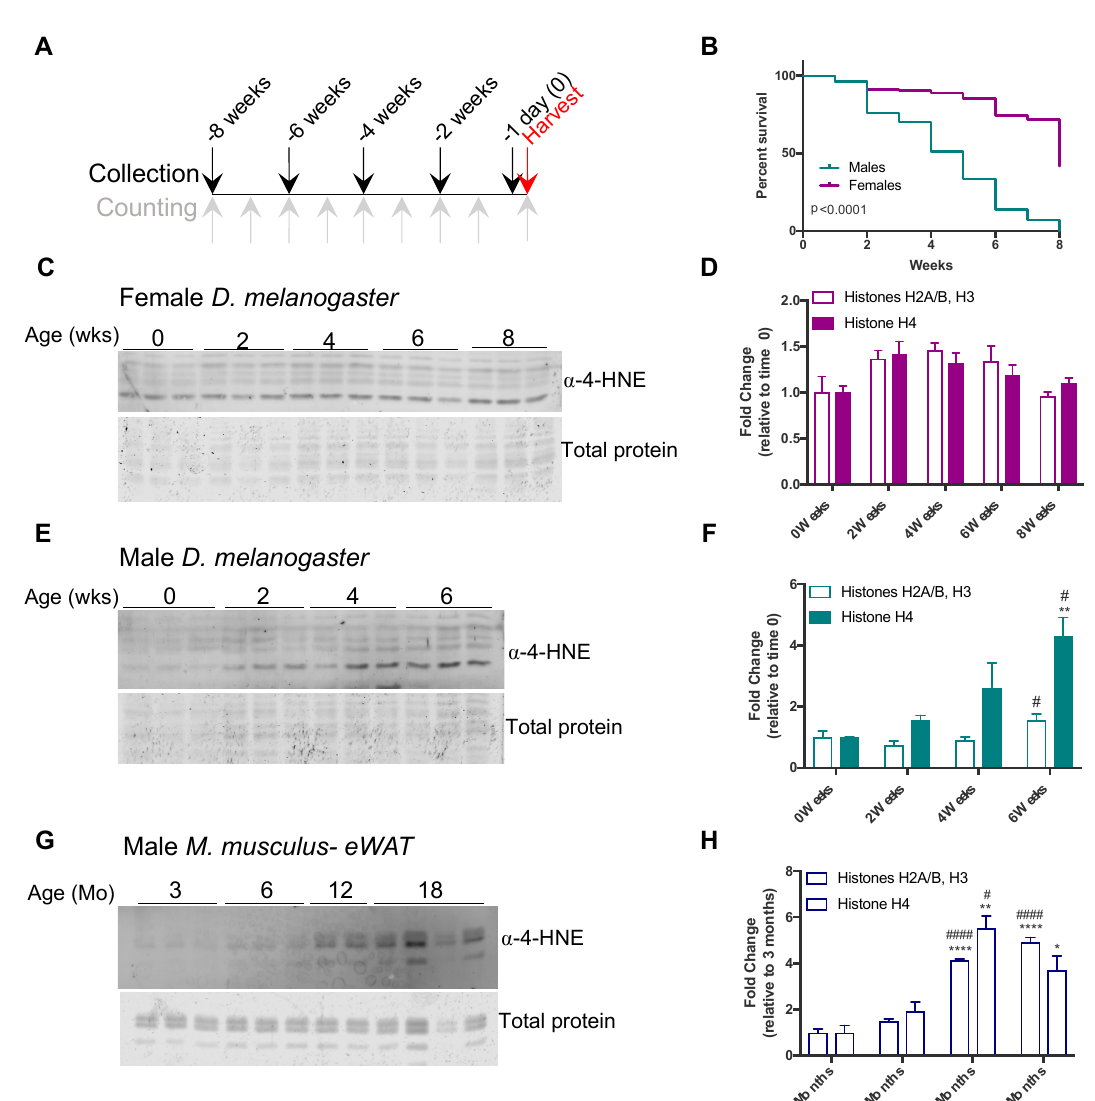
Figure 2. Histone carbonylation increases with age in mice and flies. ( A ) Schematic of D. melanogaster aging experimental design. Flies were collected every two weeks for 8 weeks and aged until the end of the study (harvest). Flies were counted and dead animals removed each week. ( B ) Survival curve of flies over the course of 8 weeks. p -Value determined by Log-rank test. ( C , E ) 4-HNE modification of histones purified from total fly homogenate for female and male flies, respectively. ( D , F ) Quantitation of Western blots from ( C , E ) normalized to total protein, relative to 0 weeks. ( G ) 4-HNE modification of histones purified from eWAT of mice aged 3–18 months. ( H ) Quantitation of Western blot from ( G ) normalized to total protein, relative to 3 months). In ( D , F , H ) results were compared by one-way ANOVA. * indicates significance compared to time 0 (0 weeks or 3 months). # indicates significance relative to 2 weeks in flies and 6 months in mice. (* p < 0.05, ** p < 0.005, **** p < 0.00001, #### p < 0.00001, # p < 0.05).